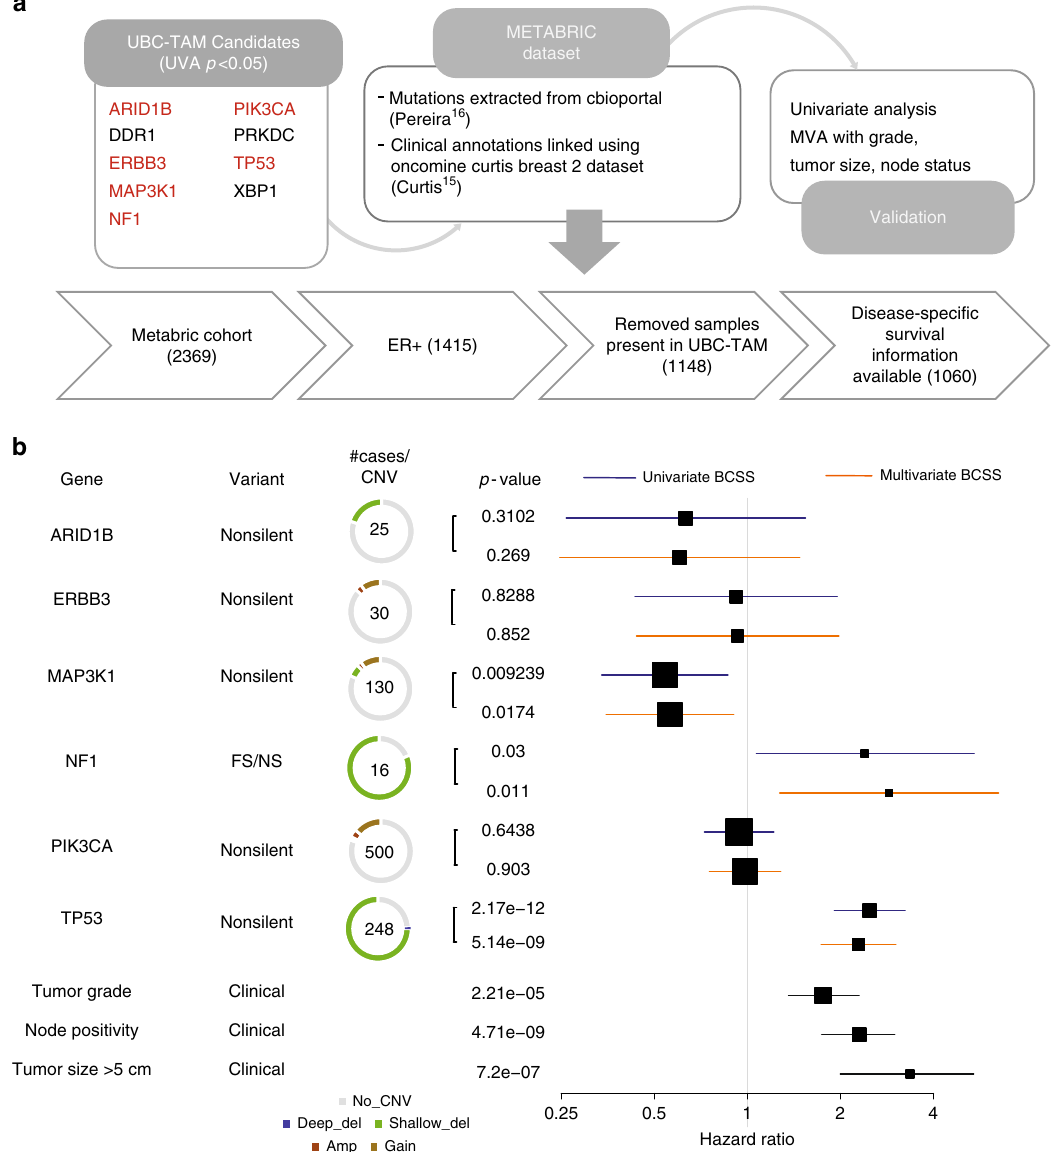
Fig. 5 Validation of UBC-TAM candidates in ER + METABRIC. a Six out of nine candidate genes from UBC-TAM analysis had mutations reported in the METABRIC cohort. 1060 ER + samples with breast-cancer-speci fi c survival information were used to test the effect of mutations in the candidate genes on prognosis. b Forest plot shows effect of mutated candidate genes on breast-cancer-speci fi c survival in METABRIC ER + cohort with univariate cox proportional-hazard ratio in blue and multivariate in orange. The clinical factors used in the multivariate analysis, namely tumor grade, node positivity and tumor size (>5 cm), are shown in black. The box size is relative to frequency of mutations in the analysis, with larger boxes representing higher incidence mutations. The # cases/CNV column shows the total number of cases with the SNV/Indel variant surrounded by a ring chart indicating the proportion of total cases with CNV alterations. Log-rank test was used to determine signi fi cance and Cox regression proportional hazards generated univariate